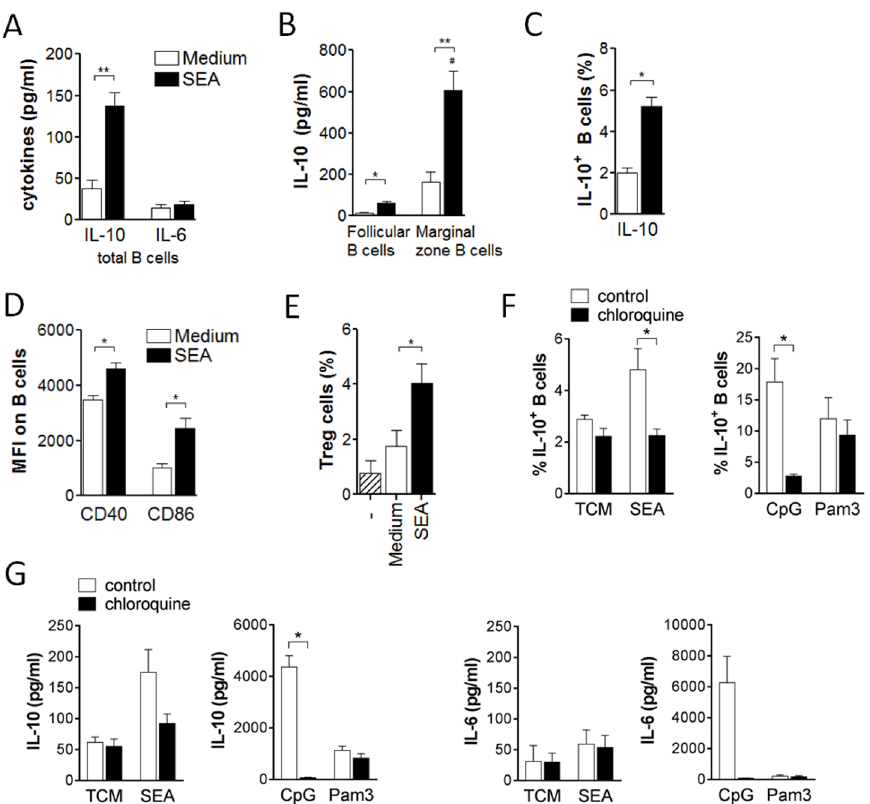
Fig 5. Breg cells can be generated in vitro by stimulation with schistosome egg antigens which involves lysosomal processing. (A-E) Splenic B cells from na ï vemice were cultured for 3 days with 20 μ g/ ml SEA or medium as control. Cytokineconcentration in culture supernatants of (A) total B cells (6 experiments) or (B) sorted B cell subsets (2 experiments with N = 6). (C) Intracellular IL-10 expressionof total B cells after additionof PMA, ionomycinand BrefeldinA to the last 4 hours of the culture (4 experiments). (D) Mean fluorescence intensity of the activationmarkers CD40and CD86 (4 experiments). (E) Splenic B cells were stimulated in vitro as above, and subsequently co-culturedwith CD4 + CD25 - sorted splenicT cells. After 4 days, the frequency of CD25 + Foxp3 + Treg cells within the CD4 T cell populationwas determined by flow cytometry. Summary of 4 experiments. (F, G) Splenic B cells from na ï vemice were cultured in vitro with SEA (20 μ g/ml), CpG (5 μ g/ml) or Pam3Cys (10 μ g/ml) for 2 days. Every day, chloroquine (5 μ M) was added to the culture. IntracellularIL-10 expressionafter additionof PMA, ionomycinand BrefeldinA duringthe last 4 hours of the culture (F) , and cytokine concentrations in culture supernatants (G) . Summary of 2 experiments with N = 3–4. Significantdifferences are indicatedwith * p < 0.05, ** p < 0.01 and tested by Mann-Whitney. # p < 0.05 indicatessignificantdifference betweenB cell subsets by Wilcoxon